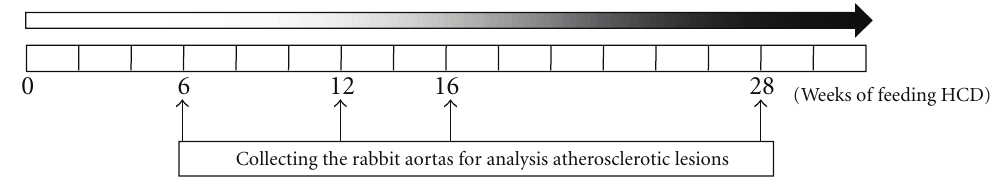
Figure 1: A schematic of experimental